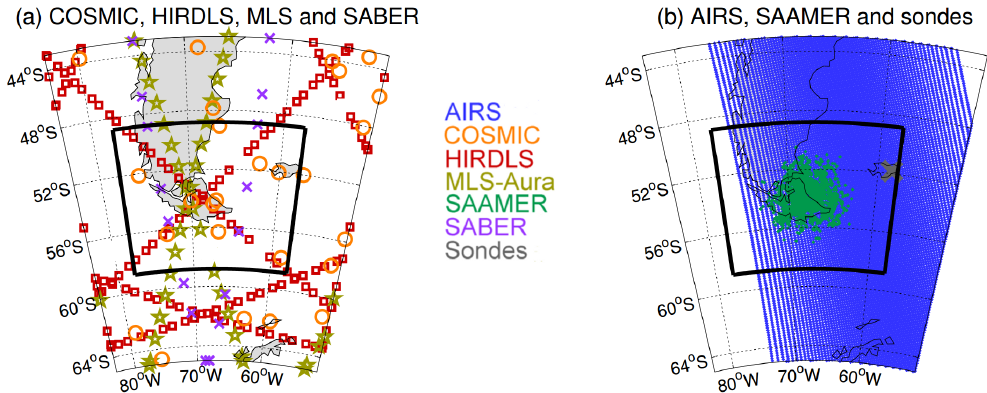
Figure 5. Panels (a) and (b) show geographic footprints of the data sets examined for a typical day (except AIRS: single descending-node pass only). The black box outlines the region averaged over for our